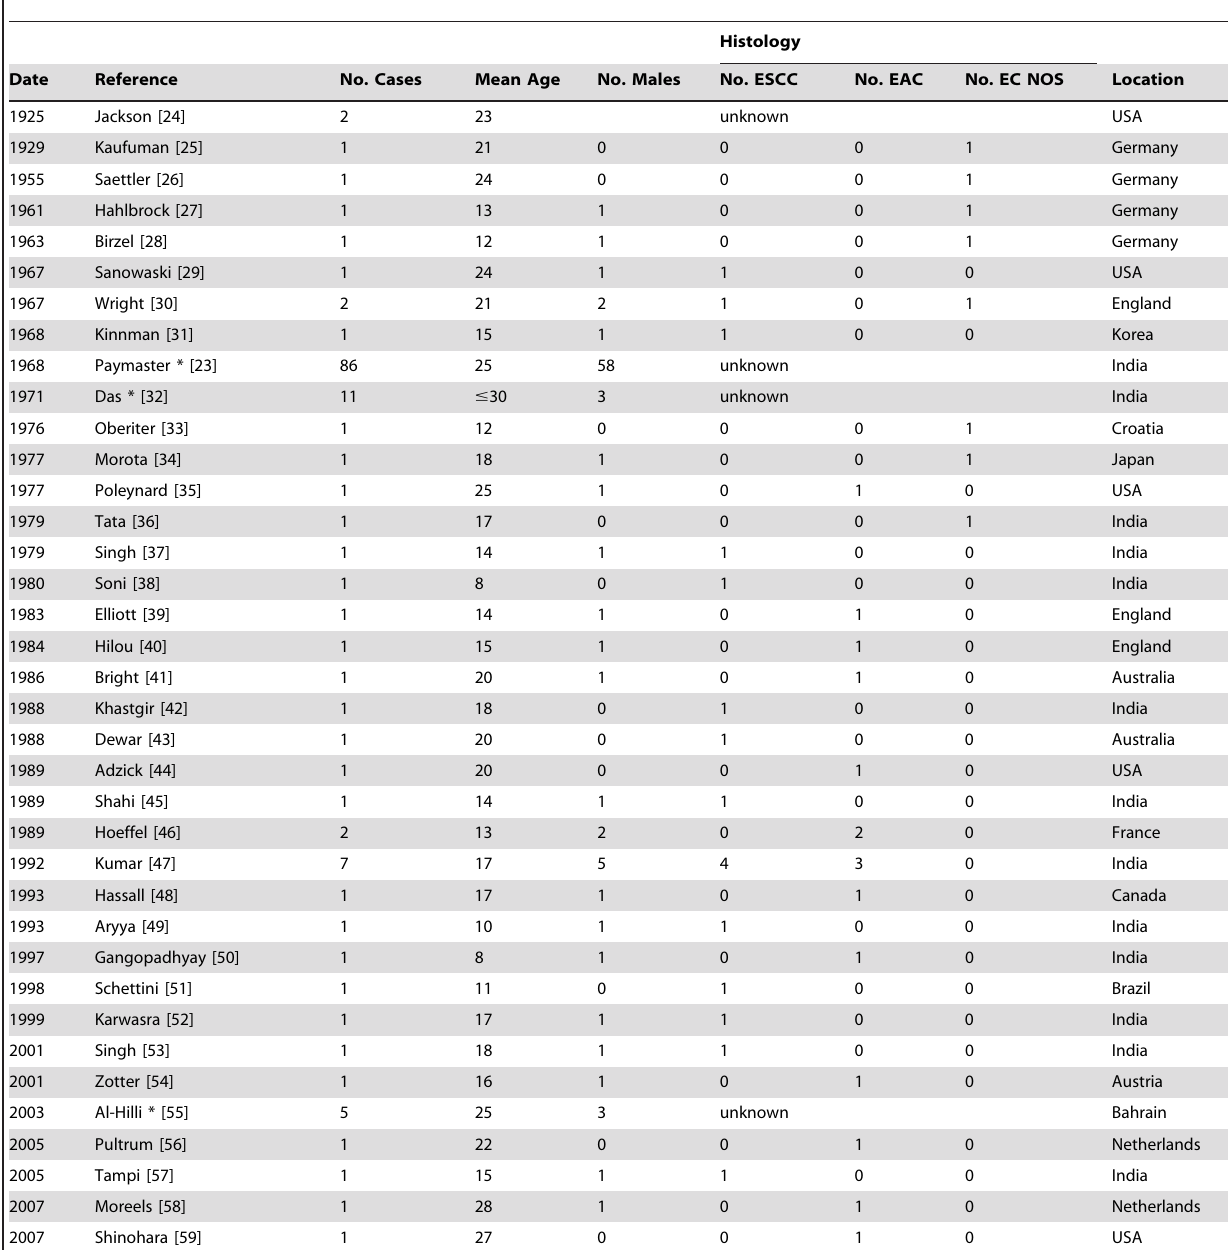
Table 4. Published papers presenting information on esophageal cancer in young